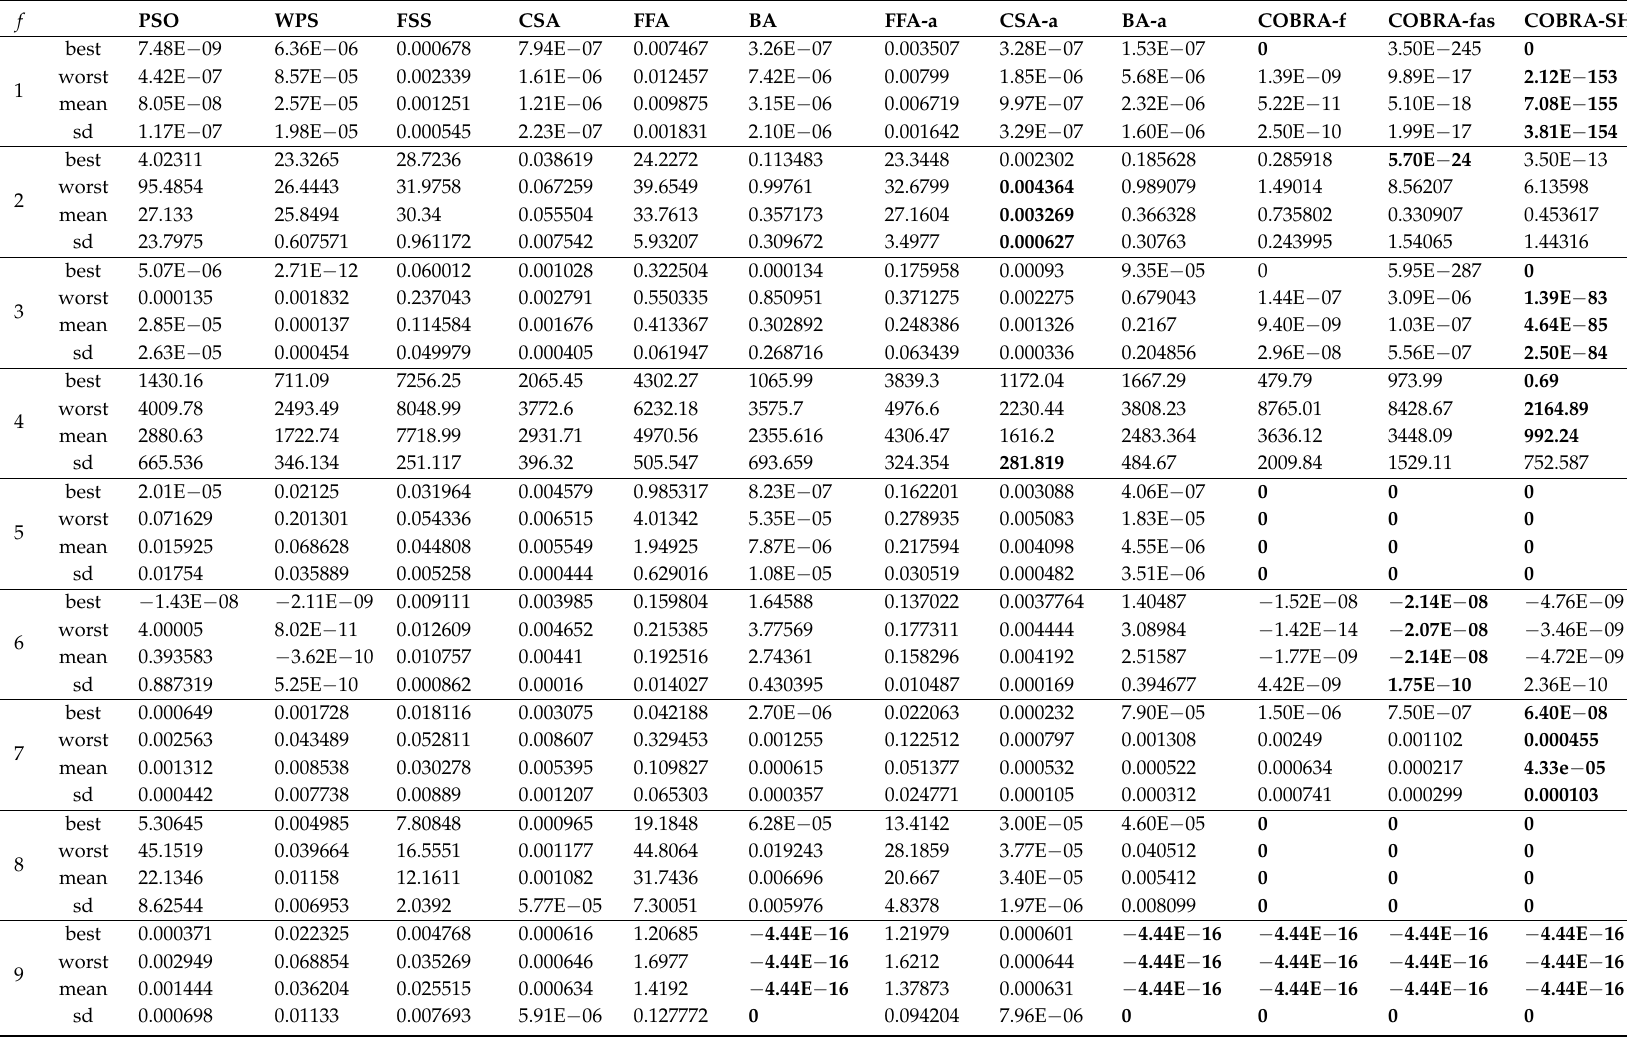
Table 5. Experimental results for 30-dimensional functions from